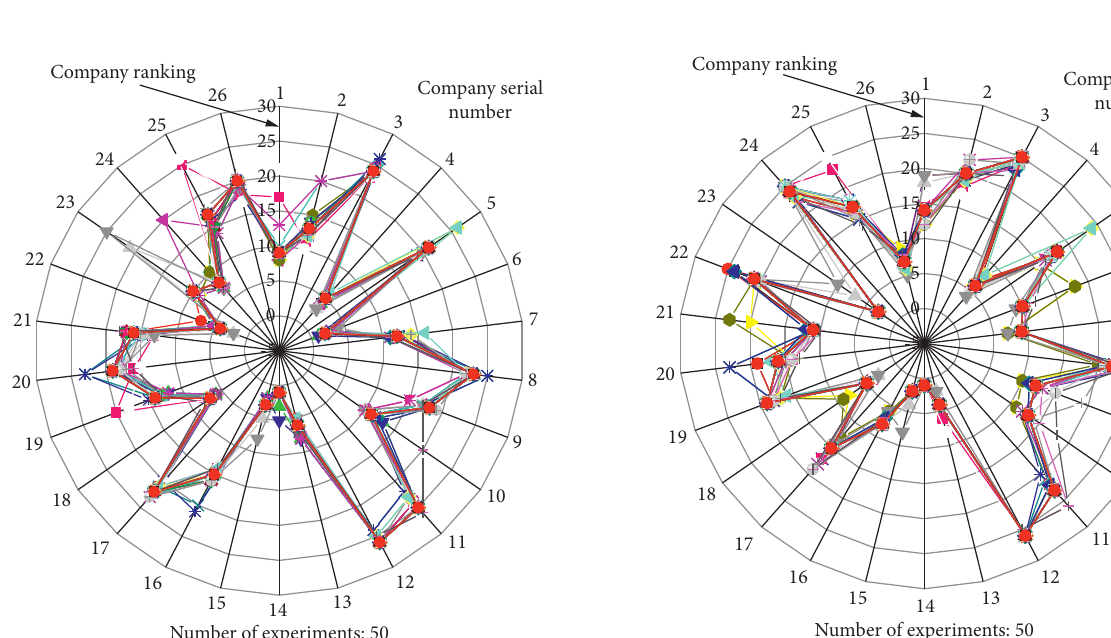
Figure 4: Weight sensitivity analysis results of the traditional VIKOR method.